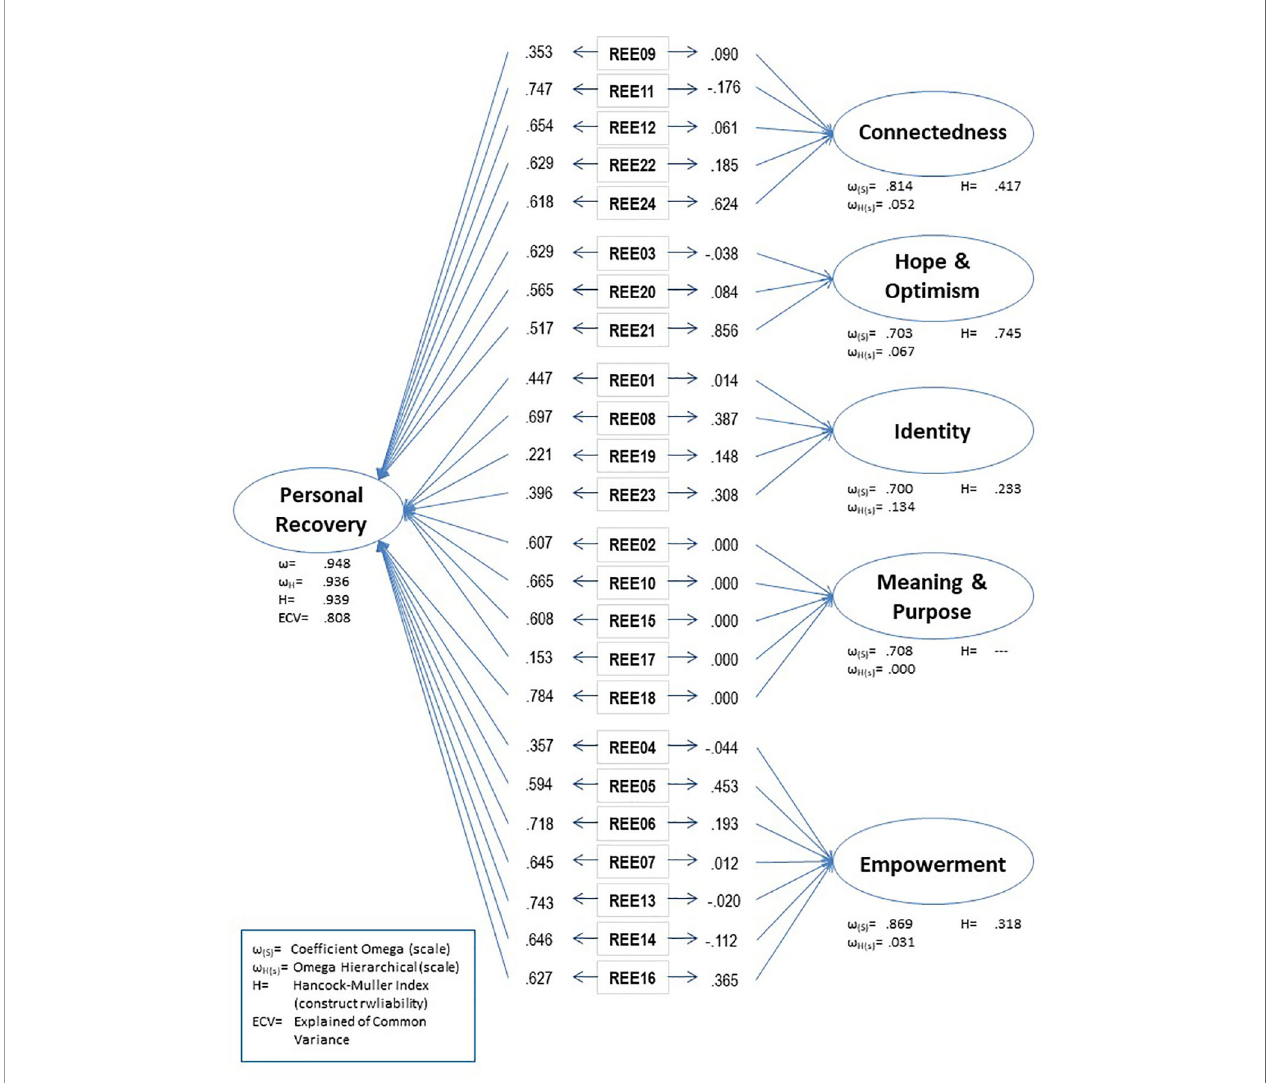
FIGURE 2 | Bi-factor model structure of the